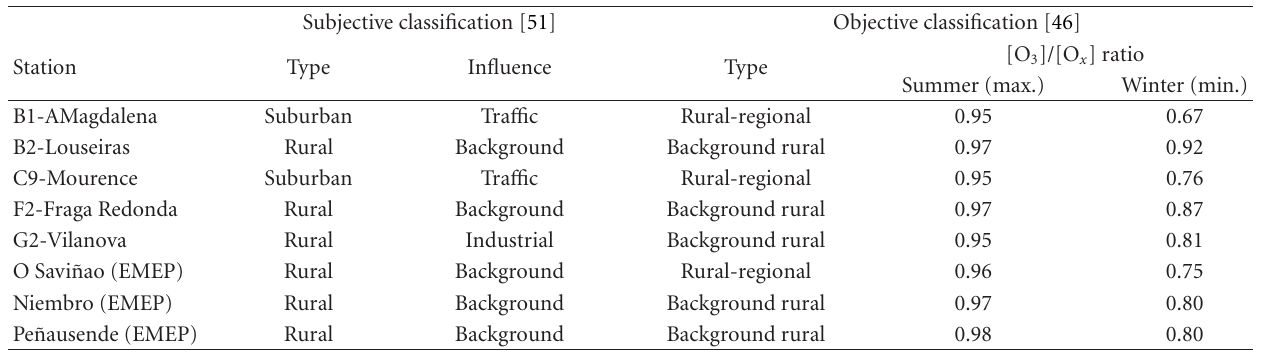
Table 4: Classification of air quality monitoring stations following the subjective [51] and objective level 1 classification [46].